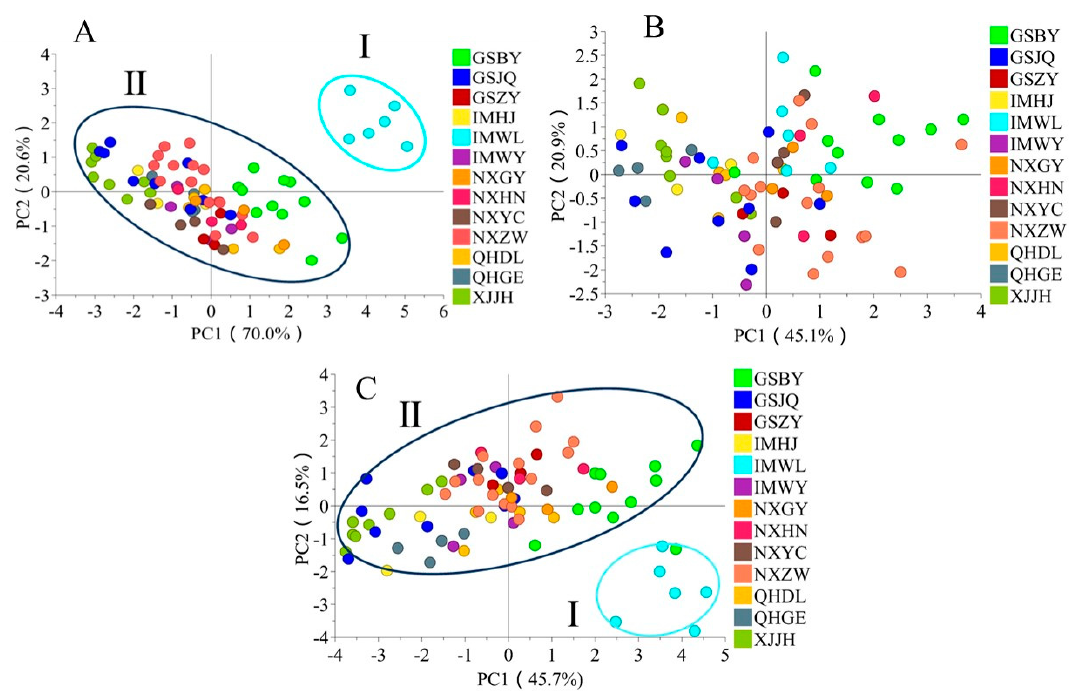
Figure 3. PCA plots of FLB from di ff erent regions with functional components (( A ) PCA plots with total and individual carotenoids; ( B ) PCA plots with the total phenolic, total flavonoid, rutin, ferulic acid, and total polysaccharide; ( C ) PCA plots with total carotenoid and individual carotenoids, total phenolic, total flavonoid, rutin, ferulic acid, and total polysaccharide).